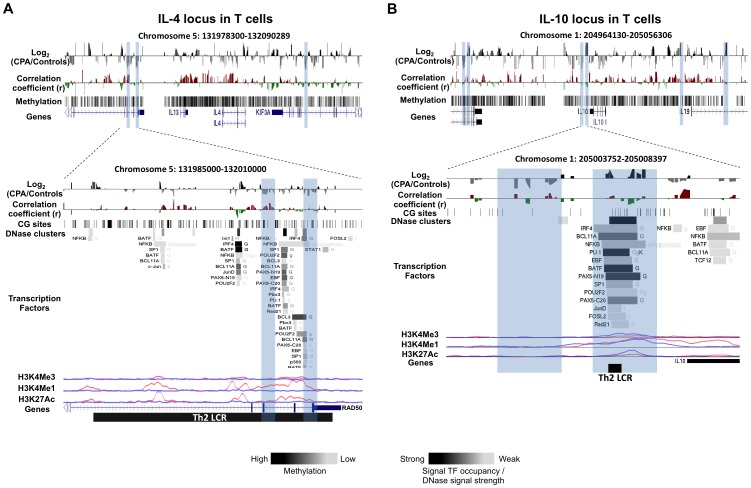
DNA methylation differences between CPA (n = 8) and control (n = 12) groups in anti-inflammatory cytokines IL-4 and IL-10 loci in T cells.Expanded views from the UCSC genome browser of IL-4 (A) and IL-10 (B) loci located on chromosomes 5 and 1 are depicted (top panel). In both panels, the first track shows the average MeDIP probe log2-fold differences (scale top panel: −0.4 to 0.4, botom panel: −1.0 to 1.0) between chronic physical aggressive (CPA) and control groups are shown for T cells. In black are probes that are more methylated and in gray are those that are less methylated in the CPA group. Highlighted in blue are regions significantly differentially methylated between the groups in T cells for IL-4 (A) and IL-10 (B). The second track shows Pearson’s correlation coefficient (scale top panel: −0.4 to 0.4, botom panel: −0.7 to 0.7) calculated between the MeDIP microarray probe intensities and the plasma IL-4 (A) and IL-10 (B) levels obtained from the same subject (n = 20). In red are probes whose methylation levels correlate positively with the cytokine level in plasma and in green are those that correlated negatively. In the top panel, the last track shows the average methylation level for all the subjects in T cells for IL-4 (A) and IL-10 (B) estimated from the microarray data. The bottom panel shows differentially methylated regions located within known Th2 LCRs where the CPA group is found significantly less methylated than the control group in the IL-4 locus (A) and significantly more methylated in the IL-10 locus (B). For the first differentially methylated region in IL-4, an overall positive correlation between methylation and IL-4 level in plasma is observed but did not reach significance after correcting for multiple testing (A, bottom panel). In the region more methylated in the CPA group of the IL-10 locus (B, bottom panel), the overall correlation with IL-10 level in plasma is negative although not significant after corrections for multiple testing. The regulatory elements from ENCODE identified in these regions (see methods) are shown in the additional tracks. First, shown with black lines, is the location of individual CpG sites. Second, is the location of DNase hypersensitive clusters where black indicate strong signal and grey a weaker signal from ChIP-seq data in 24 cell lines. Third is the location of transcription factors (TF) identified from ChIP-seq data in 24 cell lines where black indicate a strong and grey weaker signal occupancy. The letter next to the TF boxes identified the cell line where it was found enriched (see Table S1 for the full legend). The last tracks, identified the level of enrichment of three histone marks determined from ChIP-seq assay, histone 3 lysine 4 tri- and mono-methylation as well as histone 3 lysine 27 acetylation in two cell lines, GM12878 (pink) and K562 [106].